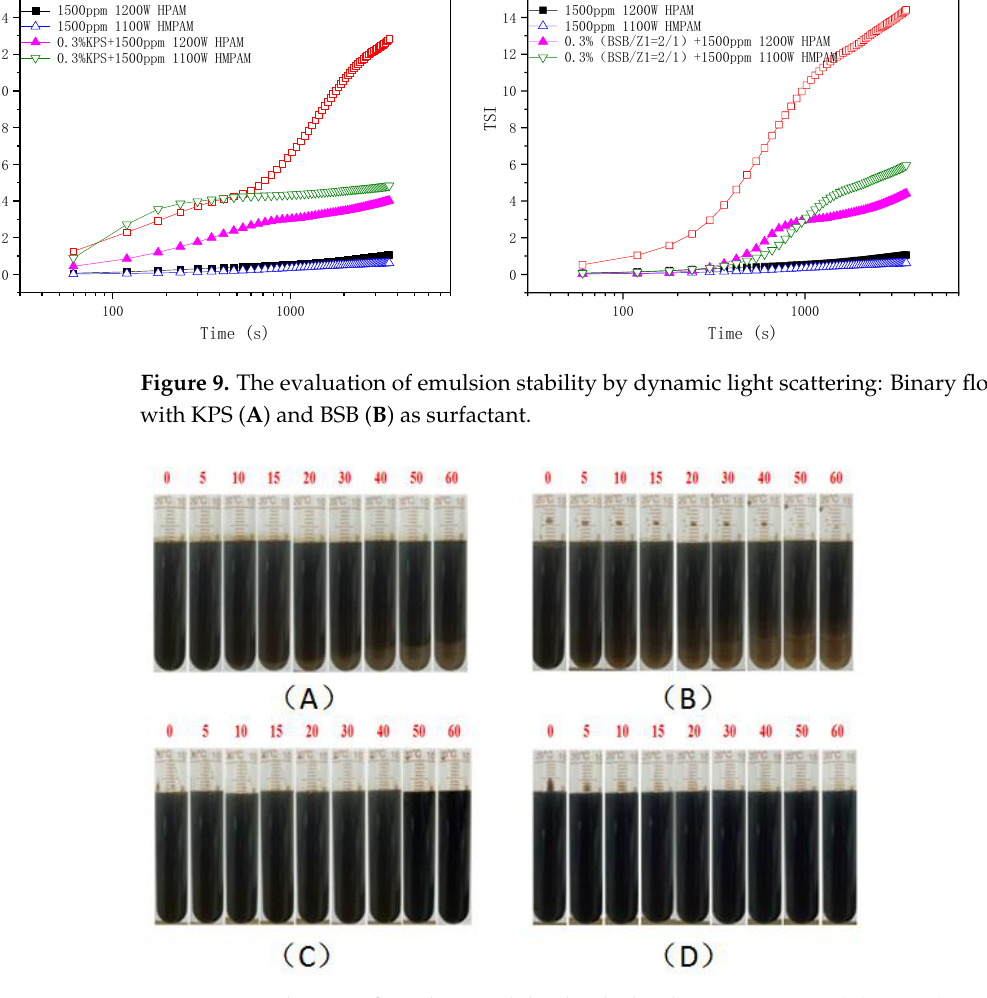
Figure 10. Evaluation of emulsion stability by the bottle test: 0.3% KPS ( A ), 0.3% (BSB/Z1 = 2/1) ( B ),